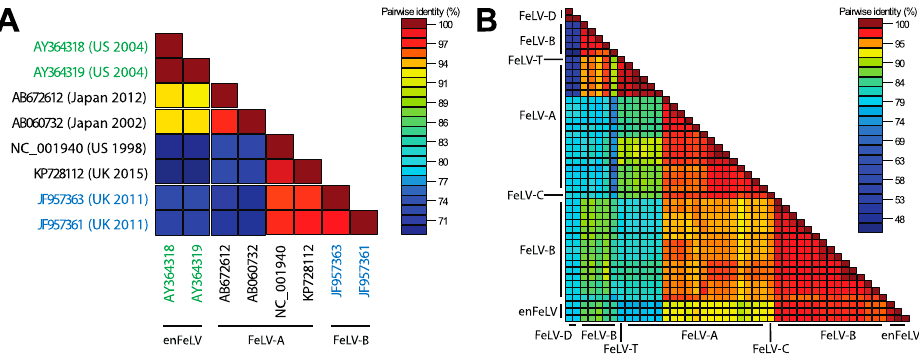
Figure 3. Pairwise identity across FeLV subytpes. ( A ) Full genomes of enFeLV (green font), FeLV-A (black font), and FeLV-B (blue font) document discrimination of two major groups (indicated by blue/green grid and yellow/red grid). Pairwise identify is indicated by color scale of intersecting grid blocks. FeLV-A is highly conserved (>94% pairwise identity), though two subgroups are indicated by red versus yellow-orange grid colors. Isolates demonstrate great variation between clades (70–77% pairwise identity with highest conservation in gag and pol ), although genetic similarity is not entirely driven by subgroup; ( B ) pairwise identity of the env genes demonstrates that this region is most divergent among FeLV subgroups. Sequence accession numbers used for